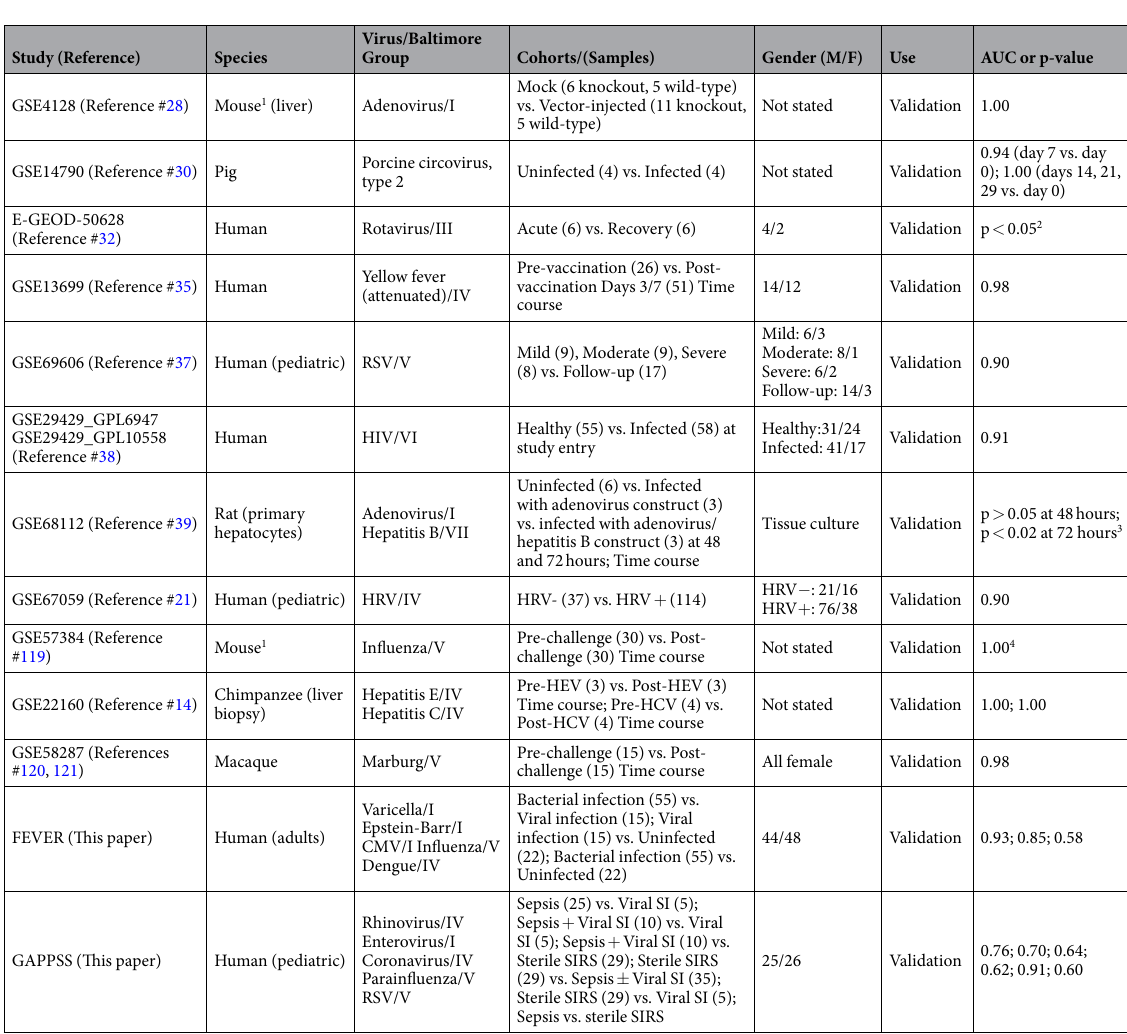
healthy controls to either the untreated African patients (panel A) or the treated American patients (panel B). The pan-viral signature AUC when comparing the untreated African patients to the corresponding healthy African controls remained at or above 0.9 at all time points; in contrast, the AUC when comparing the treated American patients to the corresponding healthy American controls dropped from above 0.9 at enrolment to less than 0.5 by Week 24 (panel C). The decrease in pan-viral signature values in the treated American patients also reflected a corresponding decrease in mean HIV-1 viral loads from ~800,000 virus particles/mL blood at study entry to ~2,000 virus particles/mL blood by week 24. GEO Validation Dataset #7: Hepatitis B (Baltimore Group VII, double-stranded DNA virus, replicating through a single-stranded RNA intermediate). We analyzed GEO dataset GSE68112 which was generated from a study of HBV infection of primary rat hepatocytes 39 . Figure 6 shows pan-viral signature scores over a 72-hour period in primary rat hepatocytes. In this study, primary rat hepatocytes were plated at 0 hours, then infected with an adenovirus-based construct containing either the gene for Green Fluorescent Protein (GFP) alone, or a copy of the Hepatitis B Virus (HBV) genome in combination with the GFP gene. Post-infection, an increase in the pan-viral signature score was observed in rat hepatocytes infected with the adenovirus + GFP + HBV construct, compared to infection with the adenovirus + GFP construct lacking HBV. At the 48 hour timepoint, this increase